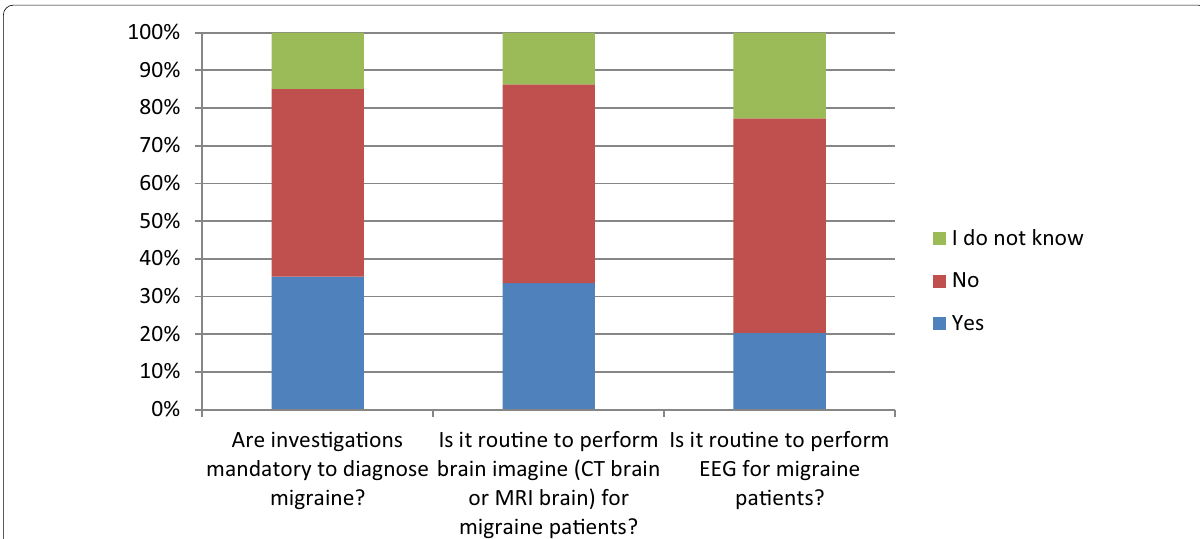
Fig. 4 Knowledge regarding investigations for migraine. CT computed tomography, MRI magnetic resonance imaging, EEG electroencephalogram